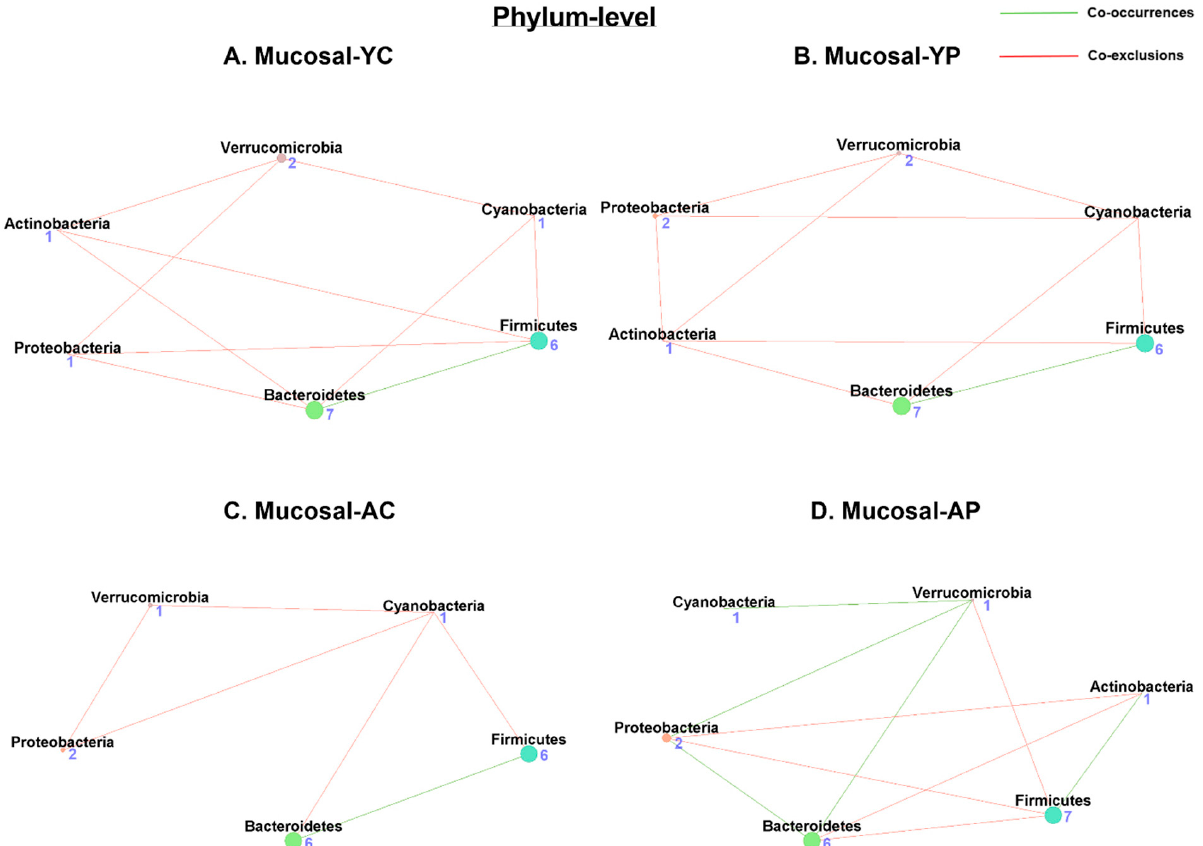
Figure 7. Microbial co-occurrence in the mucosal microbiome in young and aging mice at the phylum level. Co-occurrence networks were constructed based on relative abundance profiles using Kendall’s Tau correlation analysis in young control ( A ), young probiotic ( B ), aging control ( C ), and aging probiotic ( D ) groups. Each node represents a phylum. Each edge indicates the sign of the association (green = positive (co-occurrences), red = negative (co-exclusions)). The thickness of the nodes represents the level of association between taxa.